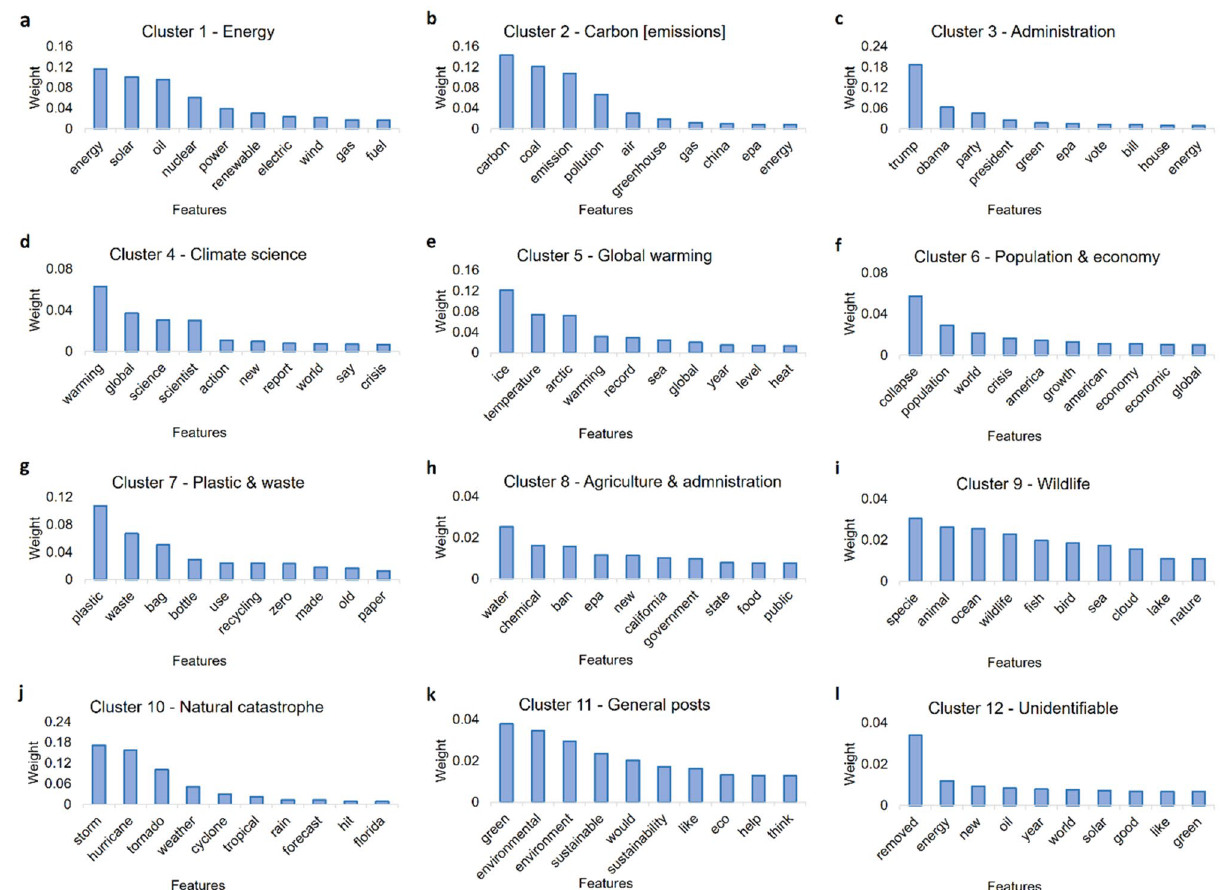
Figure 5. Showing the underlying features driving the discussions within the optimized clusters obtained for Sample 1. The underlying features are obtained by training a supervised learning-based Random forest binary classifier. From the output, we observe that all the clusters are composed of discussions related to unique themes and sub-themes within them. For instance, we obtain features such as solar, oil, nuclear, etc. in Energy cluster ( a ), and carbon, coal, emission in Carbon [emissions] cluster ( b ), whereas features such as trump, Obama, party, etc. dominate the Administration cluster ( c ). Similarly, warming, global, science, etc. comprise the Climate science cluster ( d ) whereas temperature, ice, arctic, etc. form the Global warming cluster ( e ). In the Population & economy cluster, features such as collapse, population, crisis, etc. ( f ) get the highest weightage, however, plastic, waste, bag, etc. get the highest weightage in the Plastic & waste cluster ( g ). In the Agriculture & administration cluster ( h ) features such as water, chemical, ban, etc. dominate the discussions, while in the Wildlife cluster ( i ), features such as specie, animal, fish, etc. dominate the discussions. Finally, storms, hurricanes, etc. dominate the Natural catastrophe cluster ( j ), whereas general climate-related terms such as green, environmental, etc. form the General posts cluster ( k ). The Unidentifiable cluster ( l ) on the other hand does not have a higher weightage assigned to any climate-related theme in (Fig. 8h, Extended Data Fig. S2h) are part of the Agriculture cluster, thereby clearly expressing the overall theme. Also as expected, the General posts cluster contains keywords such as “world”, “global warming”, “environmental science” etc. (Figs. 7k, 8k, Extended Data Figs. S1k, S2k), thereby showing how the discussions within those clus- ters belong to a range of climate related themes instead of specific ones as observed in the rest of the 10 clusters. Moreover, keywords such “impossible rogue”, “watch”, “online” etc. in sample 1 (Fig. 7l, Extended Data Fig. S1l) and “gang gucci”, “wedding ringer” etc. in sample 2 (Fig. 8l, Extended Data Fig. S2l) show how the discussions within the cluster titled as Unidentifiable do not relate to any climate related theme and in fact do not discuss climate at all. Apart from that, we observe words such as “renewable energy”, “nuclear”, “solar” etc. (Figs. 7a, 8a, Extended Data Figs. S1a, S2a) dominate the discussions related to Energy on Reddit, while “carbon emissions”, “coal”, “air pollution” etc. (Figs. 7b, 8b, Extended Data Figs. S1b, S2b) dominate the discussion related to Carbon [emissions] . In case of Administration , words such as “donald trump”, “green party”, “obama” etc. (Figs. 7c, 8c, Extended Data Figs. S1c, S2c) feature the discussions on Reddit climate communities. Notably, in the Climate science related discussions “global warming” features at the top of the discussions (Figs. 7d, 8d, Extended Data Figs. S1d, S2d), however words such as “climate science”, “climate crisis” etc. also feature in the discussions thereby showing how this cluster differs from the next cluster i.e. Global warming, which as expected features the “global warming”